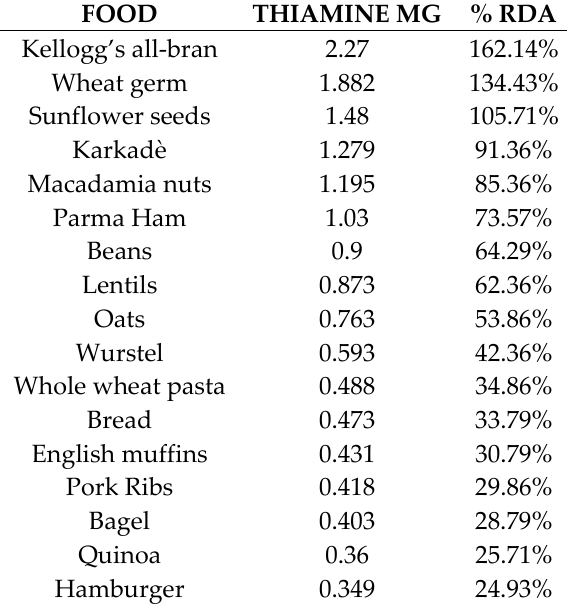
Table 1. List of foods with a high thiamine (vitamin B1) content, from the richest to the least rich. The content of thiamine (vitamin B1) refers to 100 g of edible part of each food [28,29]. RDA: Recommended Daily